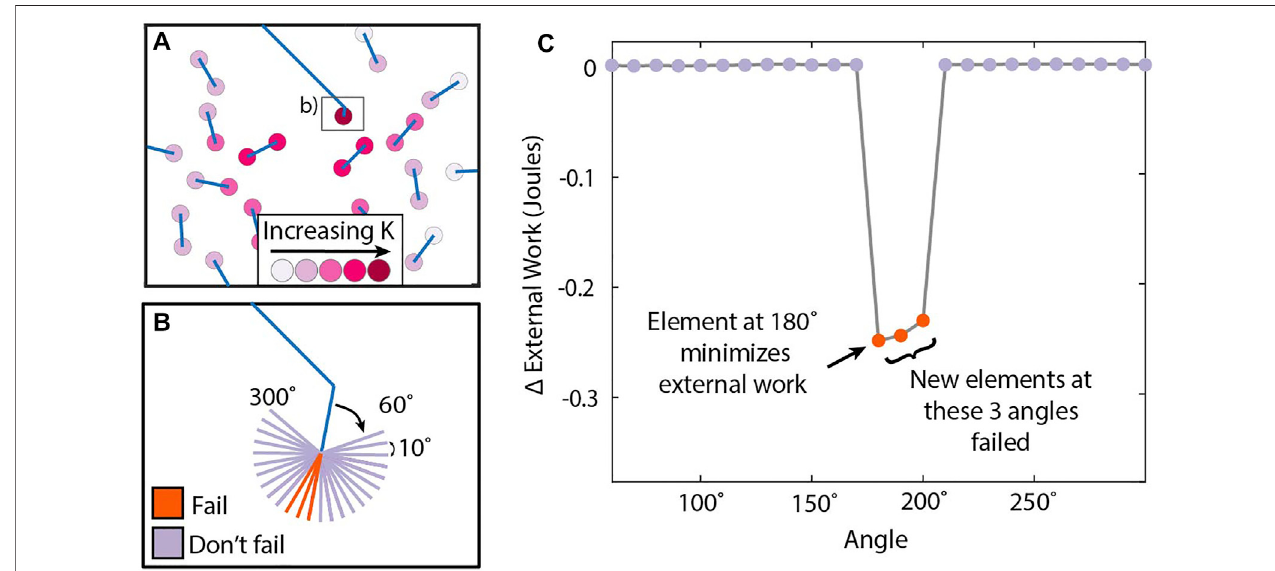
FIGURE 2 | GROW uses work optimization to predict fracture propagation. (A) Model with a long fracture surrounded by smaller fractures. Mode I and II stress intensityfactors(K)atthetipsoffracturesareusedtocalculatepropagationpotential.GROWselectsthefracturetipswithhighestpropagationpotential( Eq.1 )toassess for growth in the next step. (B) GROW assesses new growth elements at a prescribed range of angles clockwise around the fracture tip(s). For this study, we assessed 10 ° increments from 60 ˚ -300 ° . Elements can fail via slip or opening. (C) New growth elements that fail can reduce the external work on the displacement-loaded system.GROWassesseswhichorientationminimizesexternalwork,thatelementisadded,andtheprocessisiterated.Inthisexample,elementsthatpropagateat180 ° , 190 ° , and 200 ° fail, and the element at 180 ° is selected because it produces the lowest external work.